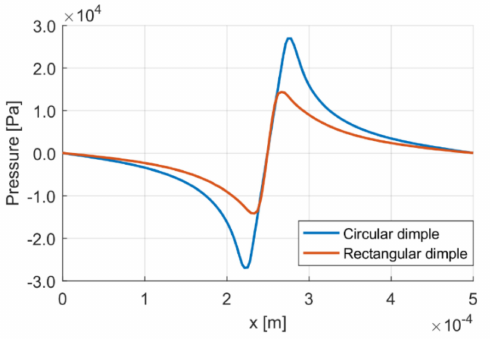
Figure 5. Pressure distributions relative to the circle and rectangular case of Figure 4, calculated along the dimples median line.